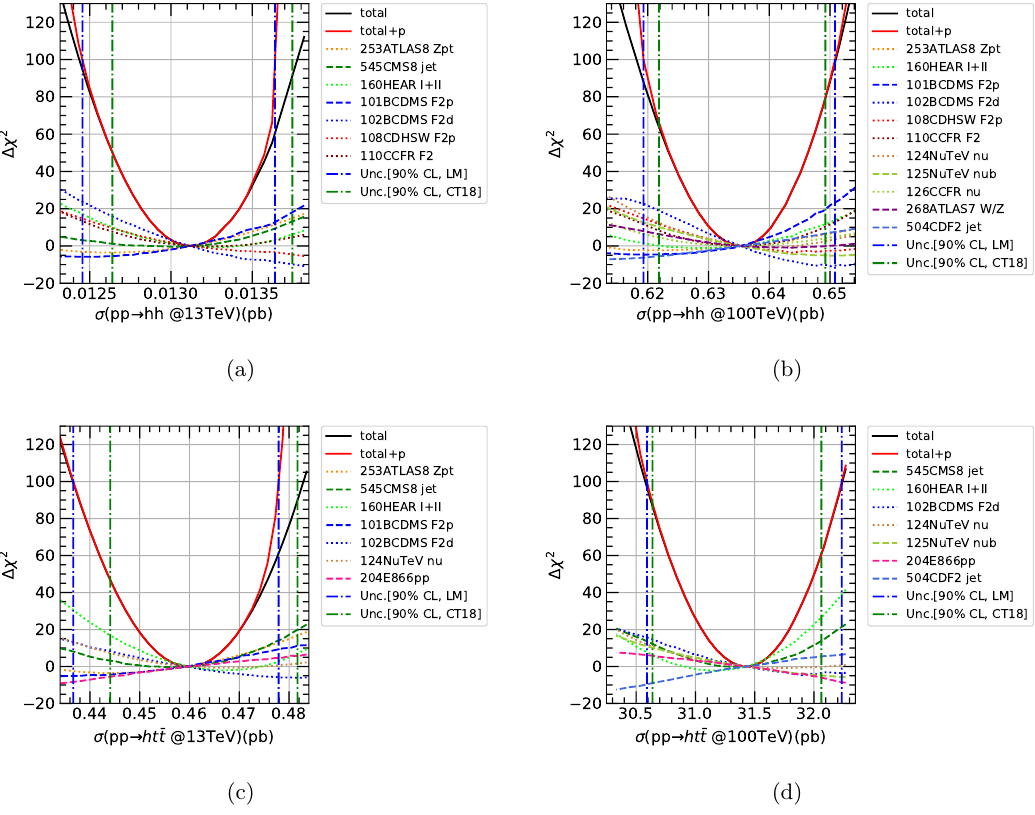
√ at s = 13 TeV or 100 pp → ht ¯ t